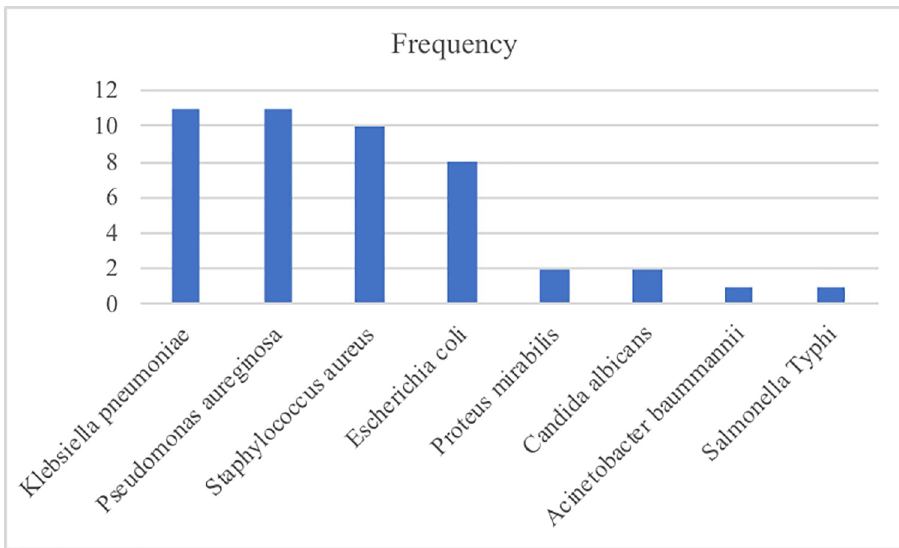
Fig 1. Bacteria isolated from patients with BSI at